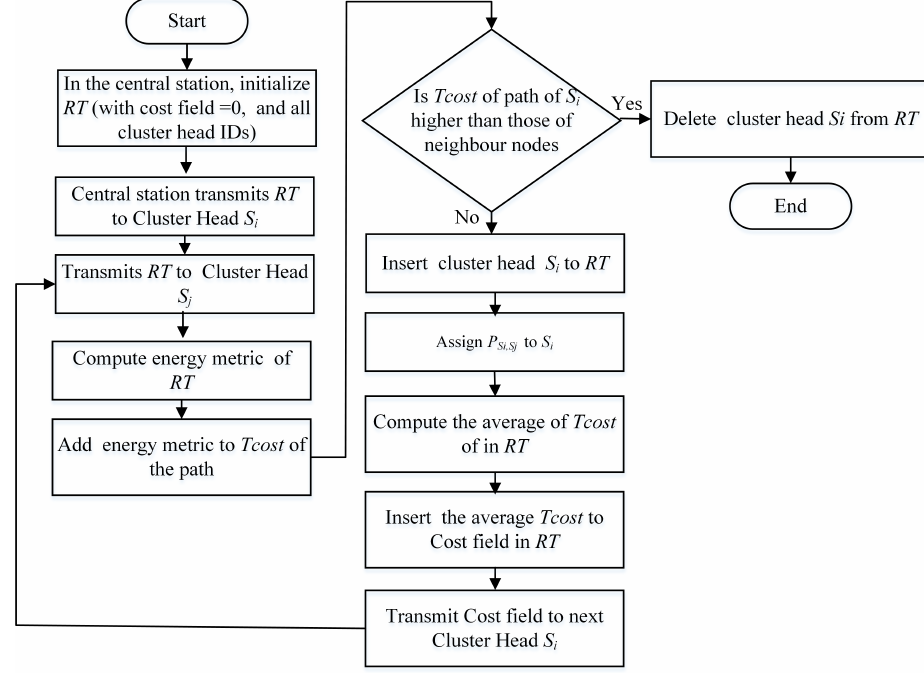
Figure 6. Inter-cluster sub-optimal multi-hop